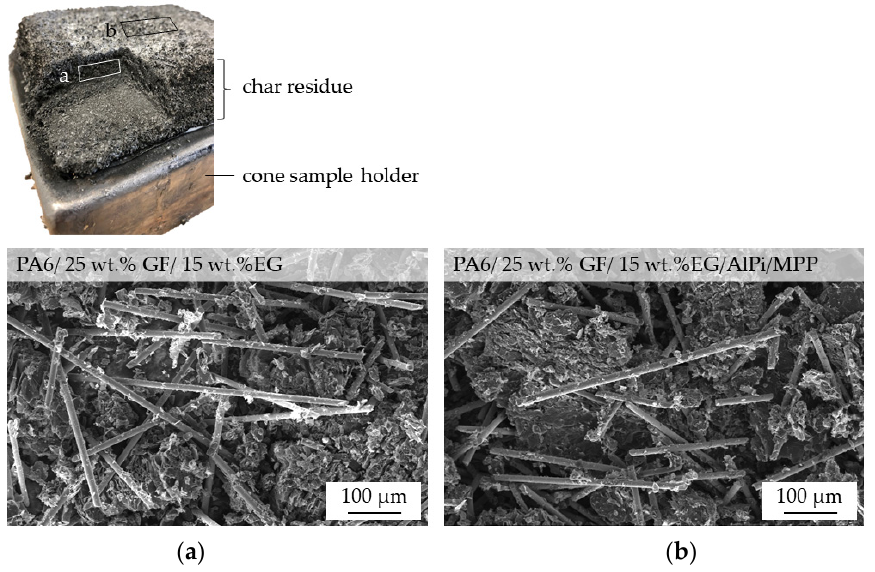
Figure 10. REM image of char residue after cone calorimeter testing: ( a ) PA6 + 25 wt.% (15 vol.%) GF + EG, ( b ) PA6 + 25 wt.% (15 vol.%) GF + EG/(AlPi/MPP 3:2).